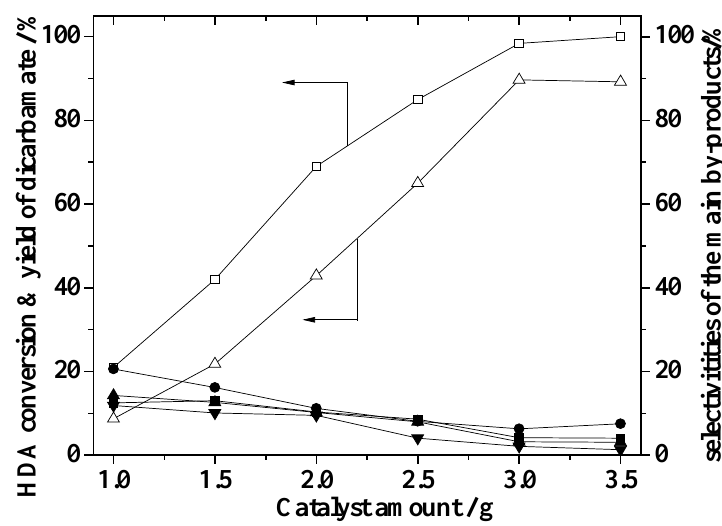
Figure 7. Effect of the amount of ZnAlPO 4 catalyst on HDA conversion, yield of 2 and selectivities for the main byproducts ( 1 , 3 – 5 ). Reaction conditions: HDA: 0.9 mol; ZnAlPO 4 : 2.0 g; butanol: 7.74 mol (708.0 mL); urea/HDA molar ratio: 2.6; reaction temperature: 493 K, reaction pressure: 1.2 MPa. (Legend: (□) HDA conversion; ( △ ) yield of dialkyl carbamate; ( ■ ), ( ▲ ), (●) and ( ▼ ) selectivity for 3 ,